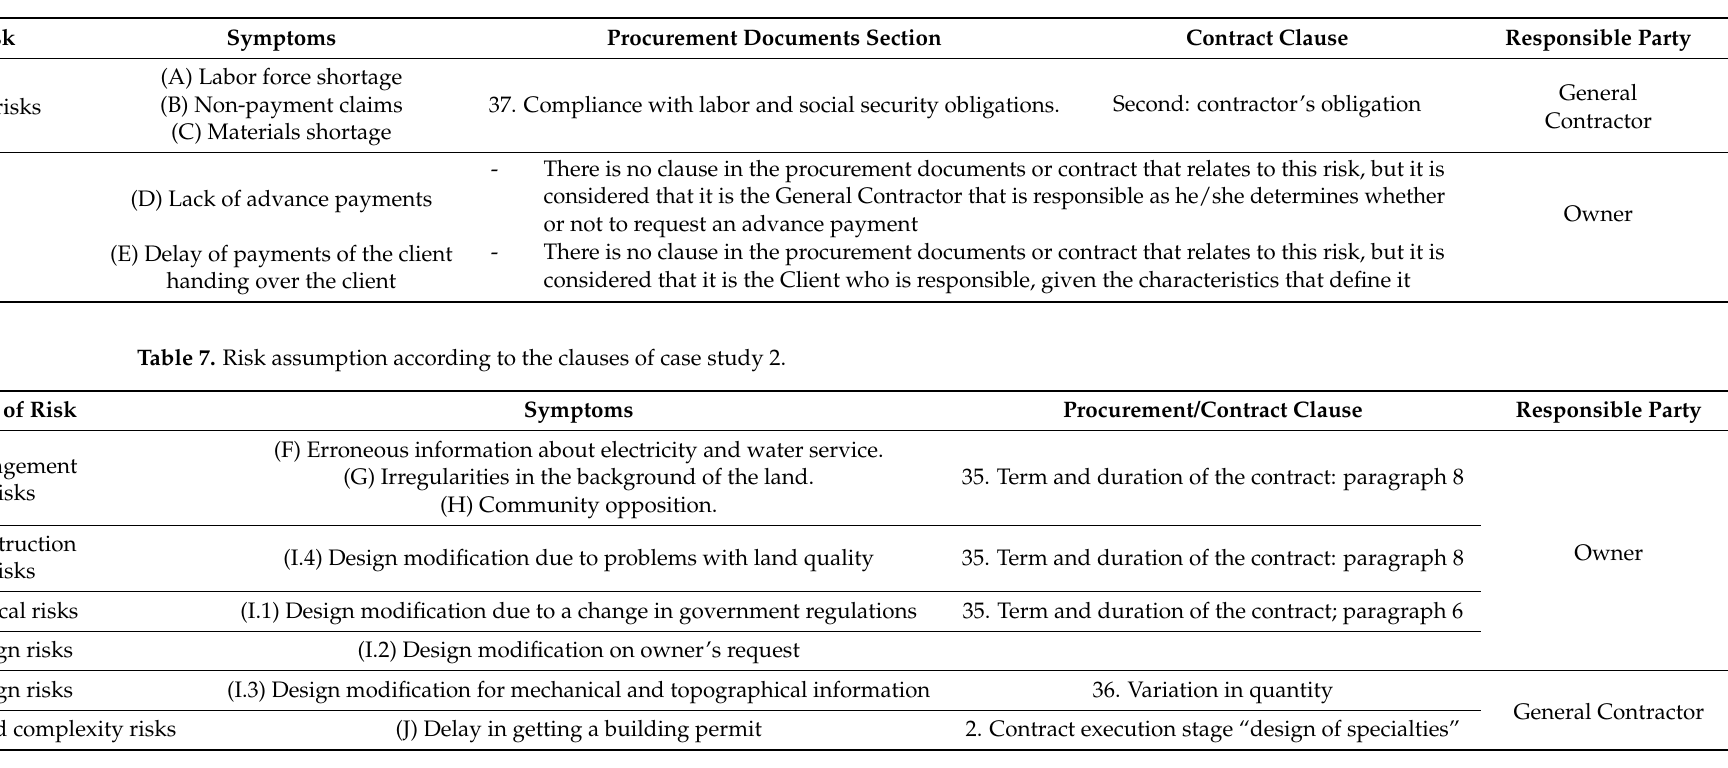
Table 6. Risk assumption according to the clauses of case study 1.